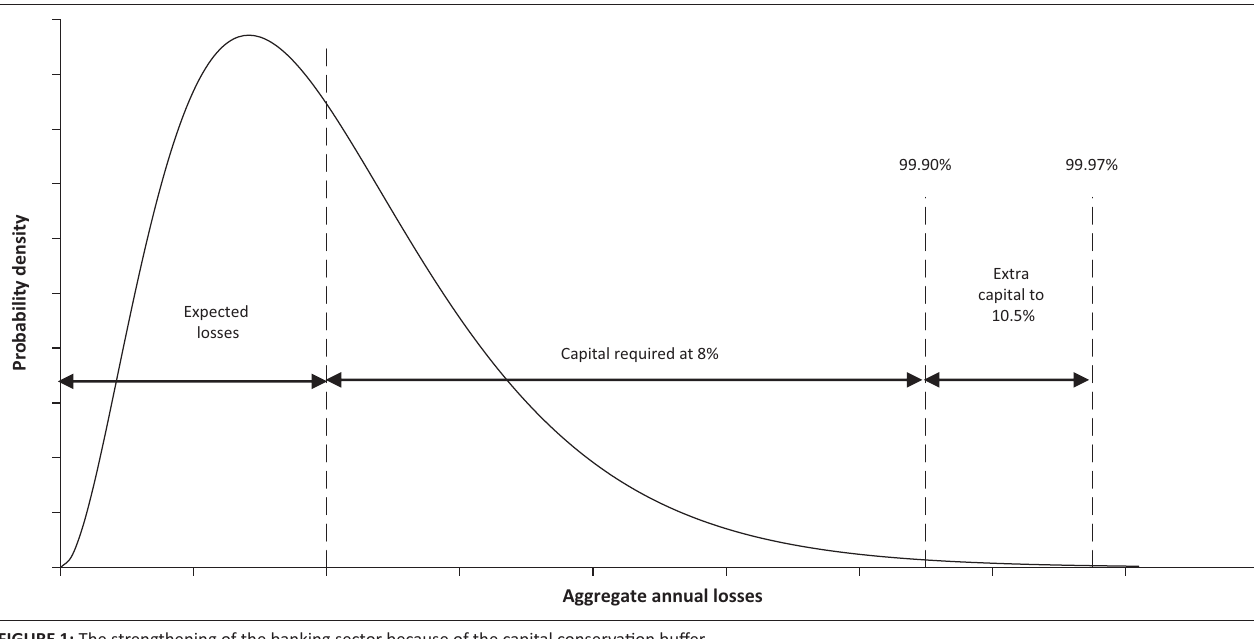
FIGURE 1: The strengthening of the banking sector because of the capital conservation TABLE 1: Proposed Basel III countercyclical rules implemented in South Africa in 2014. Minimum CCR as % of earnings